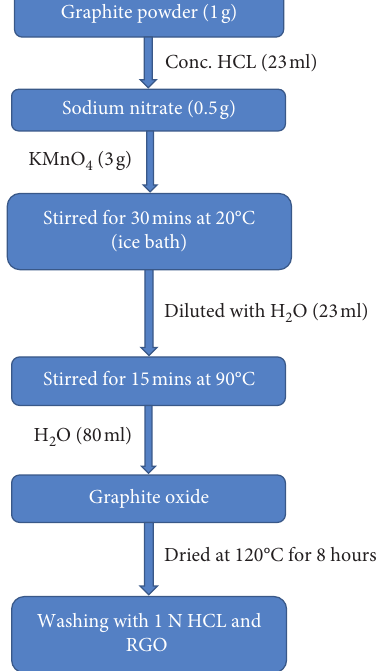
Figure 1: Process flowchart of graphene synthesis